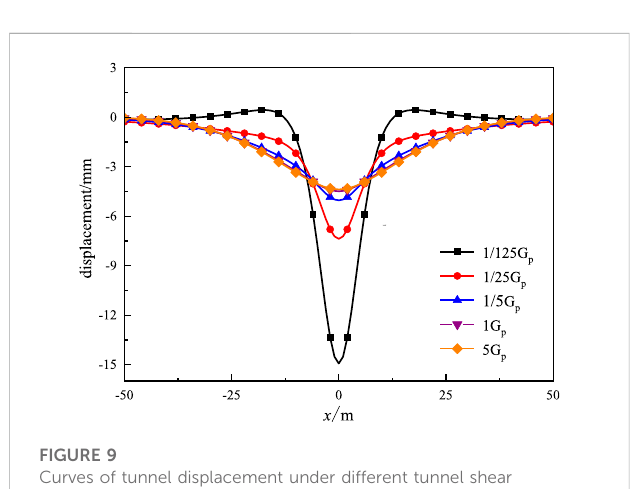
FIGURE 9 Curves of tunnel displacement under different tunnel shear modulus G p.